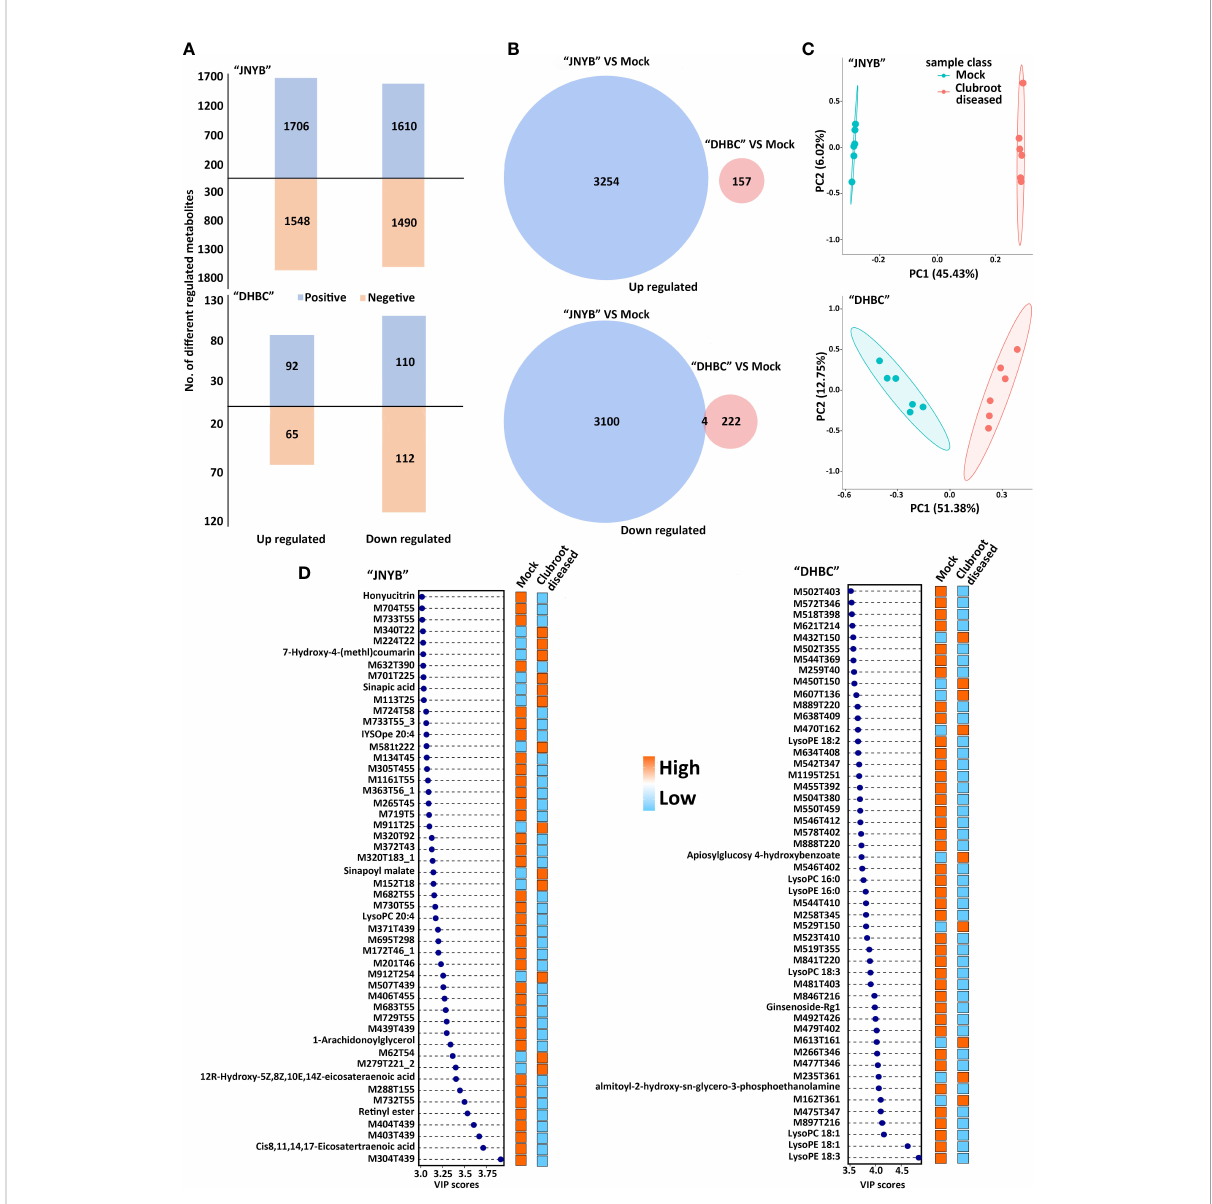
FIGURE 3 Analysis of DRMs between P. brassicae -susceptible and P. brassicae -resistant cultivars upon clubroot disease infection. (A) Number of up- and downregulated DRMs between “ JNYB ” and “ DHBC ” in positive and negative ion modes. (B) Overlap among clubroot disease-responsive metabolites between two cultivars. (C) PCA of metabolic pro fi les of “ JNYB ” and “ DHBC ” under control and clubroot disease. (D) Fifty top metabolites according to the VIP score of two cultivars in response to clubroot. Positive and negative in A refers to positive ion mode and negative ion mode,